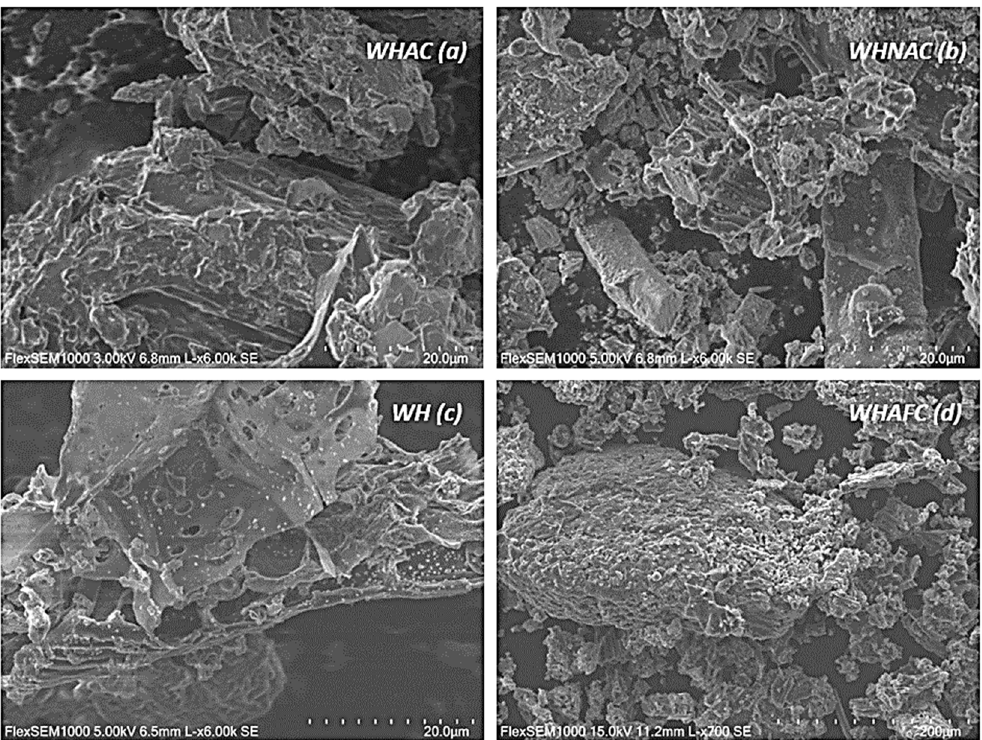
Figure 2. SEM (scanning electron microscopy) micrographs .